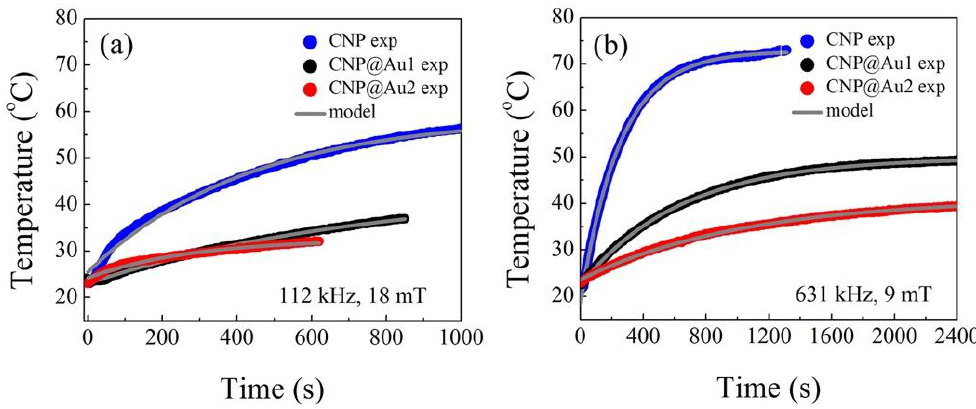
Figure 4. The temperature (°C) versus time (s) curves of the aqueous suspensions that contained MNPs (CNP, CNP@Au1 and CNP@Au2) and were under the influence of an externally AC magnetic field: ( a ) the data from an AC magnetic field amplitude of 18 mT and frequency of 112 kHz for CNP, CNP@Au1 and CNP@Au2; ( b ) the data from an AC magnetic field amplitude of 9 mT and frequency of 631 kHz for CNP, CNP@Au1 and CNP@Au2. The experimental data are represented by filled symbols and the fitting data are represented by solid gray lines.